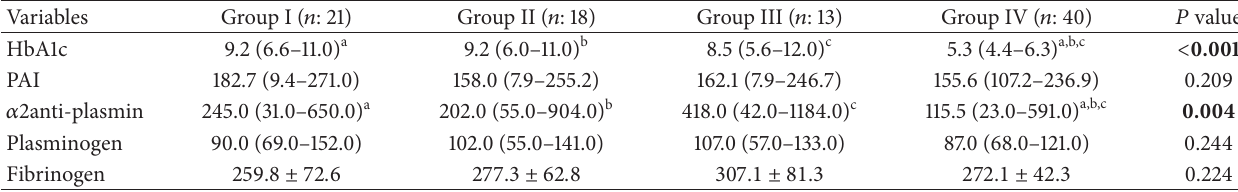
Table 2: Biochemical and hemostatic measurements of diabetic patients and healthy controls.